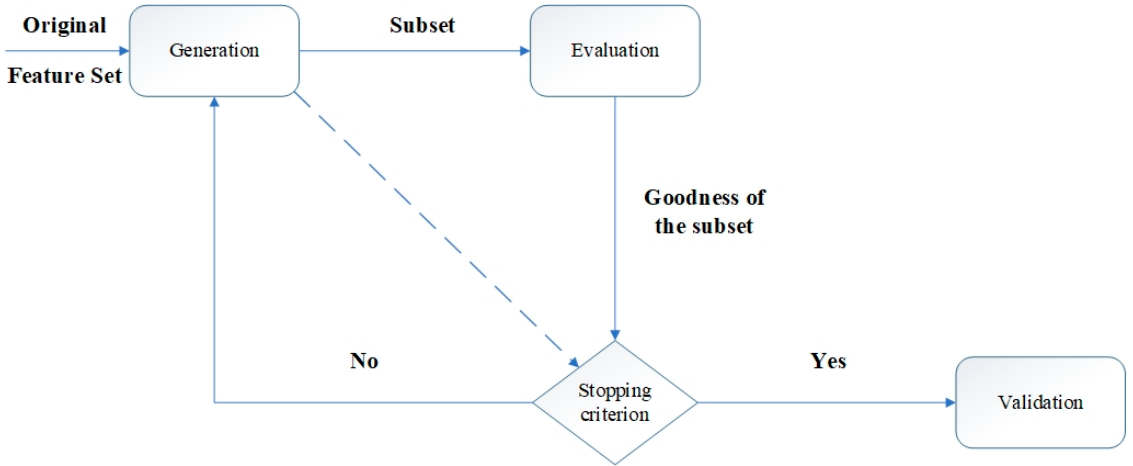
Figure 22. Feature selection technique steps.